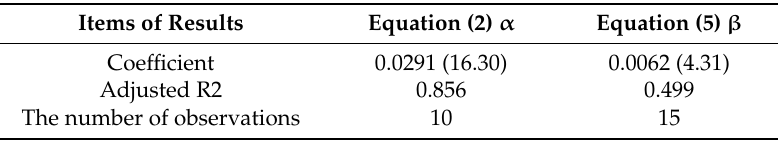
Table 2. Results of coefficient estimation.